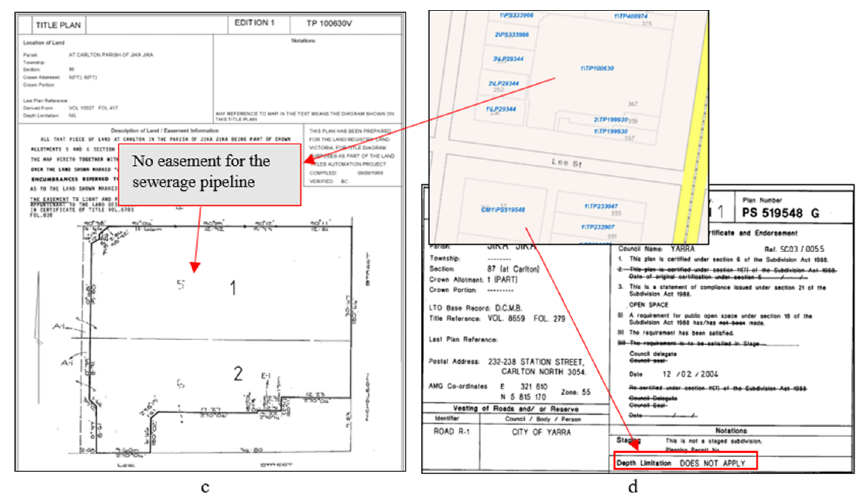
Figure 5. A sewerage network owned by Melbourne Water Corporation located under some private properties in Victoria, Australia: ( a ) pipeline location (sewerage data source: [59]); ( b ) pipeline depth; and ( c , d ) subdivision plans of two parcels above the pipeline assets (subdivision plans source: [11]).